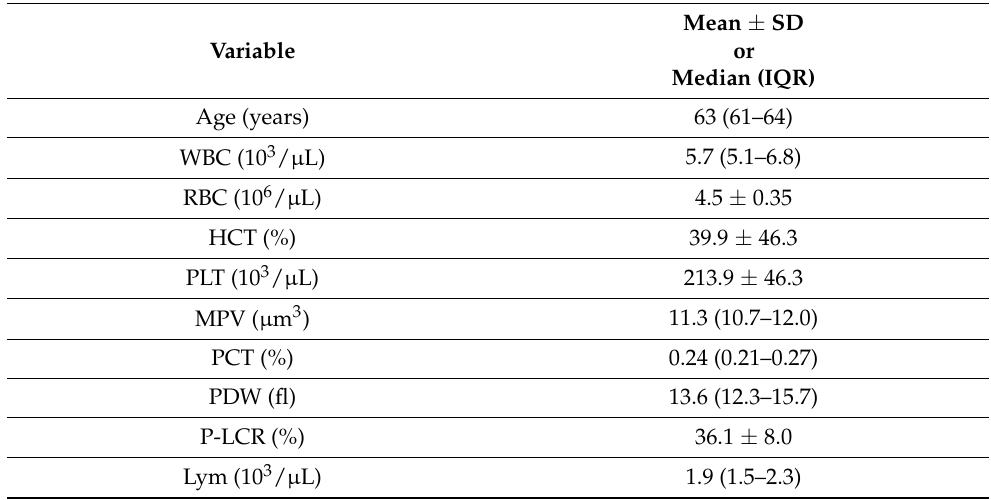
Table 1. Morphological, biochemical, and platelet function characteristics of investigated group of